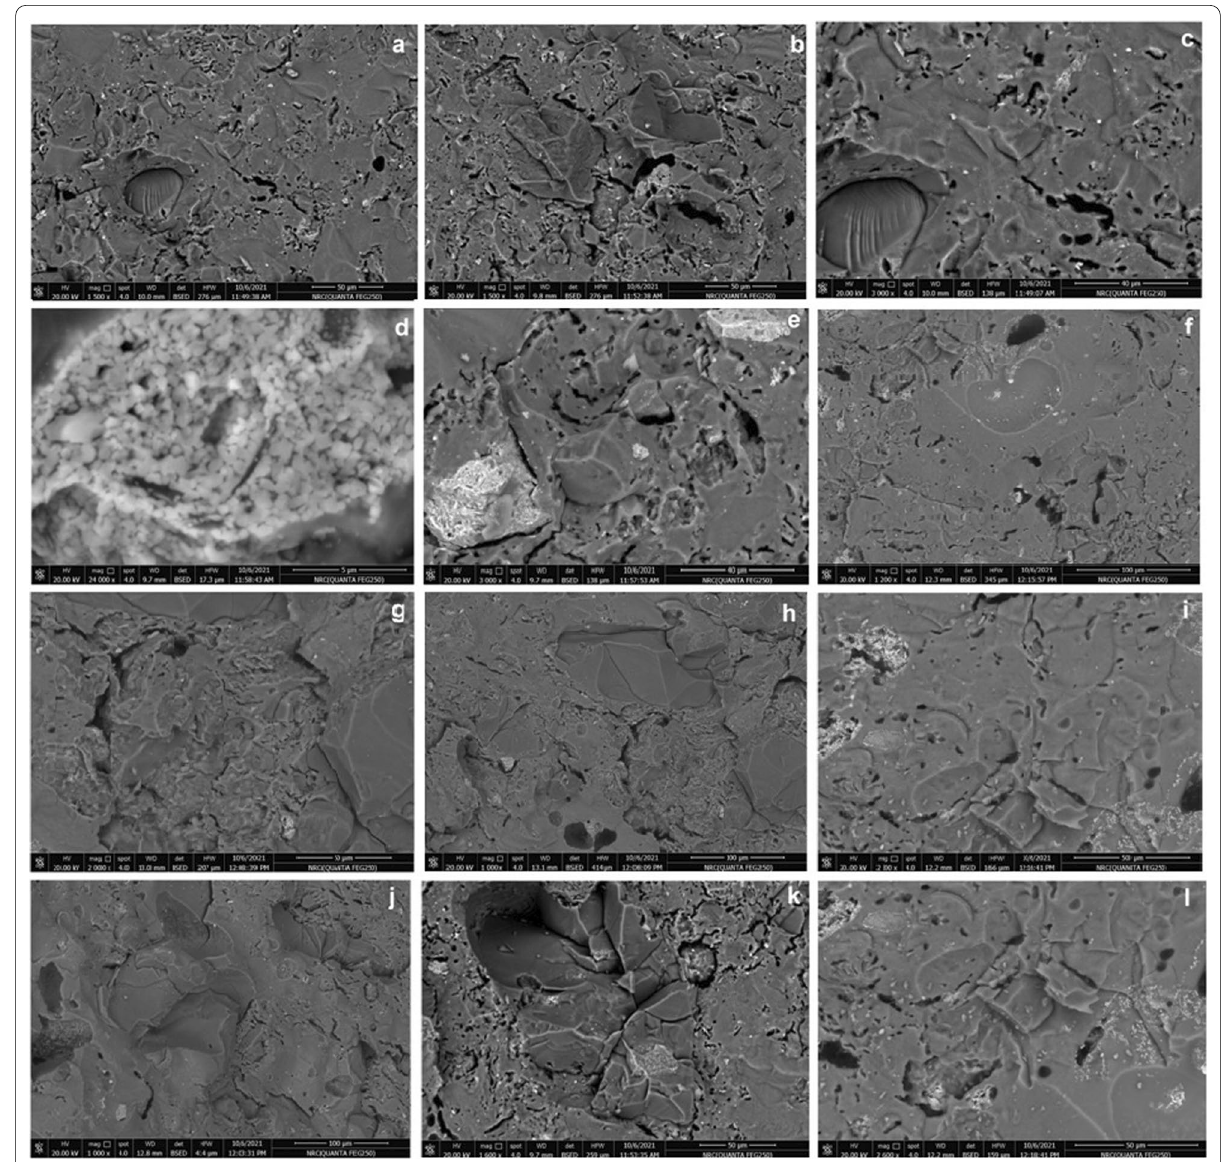
Fig. 8 SEM of the selected fired